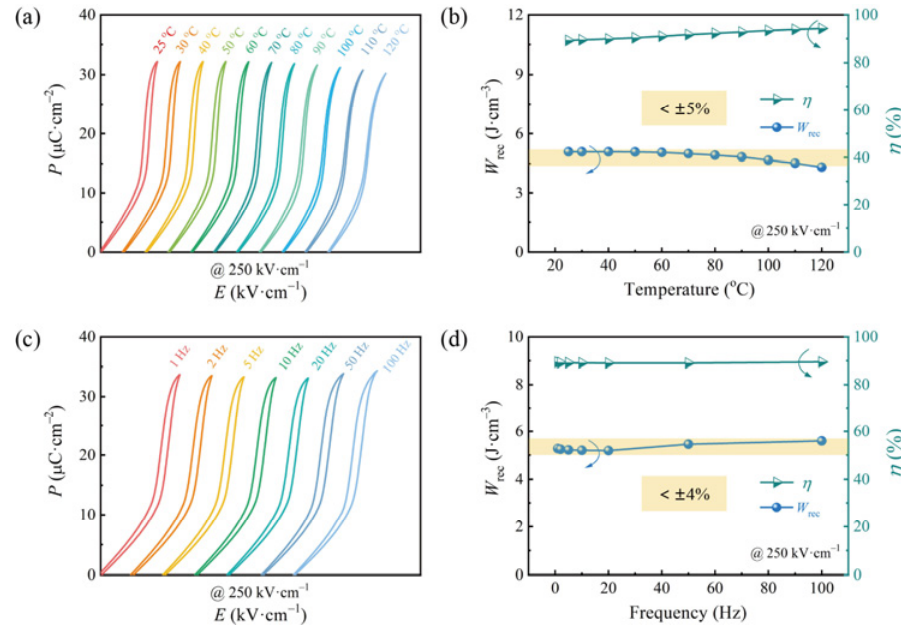
Fig. 7 (a) Temperature-dependent P – E loops of PBLZST:1.0 wt% AlN ceramics measured at 250 kV·cm − 1 and 10 Hz, and (b) the corresponding W rec and ƞ at various temperatures. (c) Frequency-dependent P – E loops of PBLZST:1.0 wt% AlN ceramics measured at 250 kV·cm − 1 and room temperature, and (d) the corresponding W rec and ƞ at various